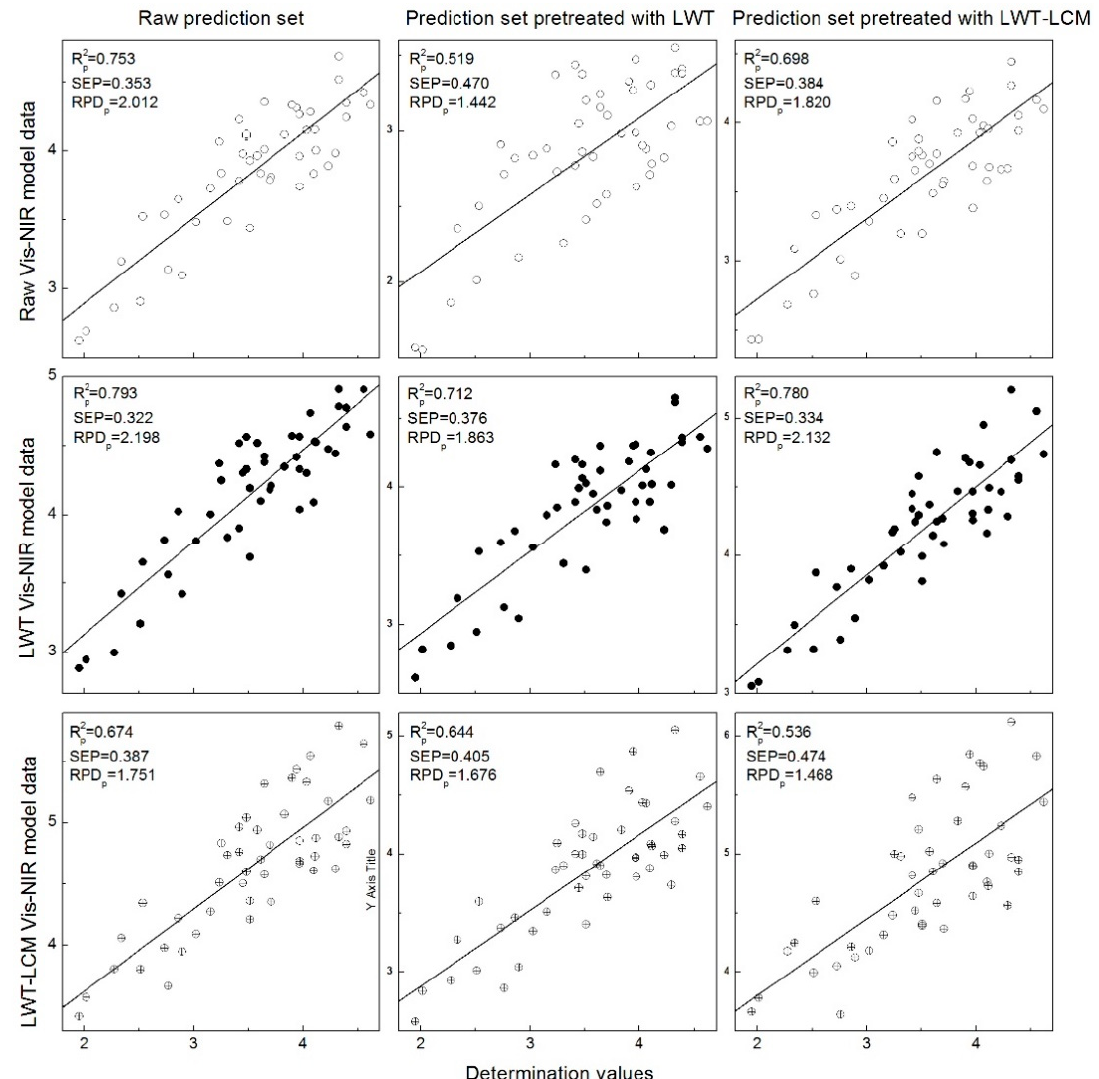
Figure 6. Predicted versus measured wood tracheid length for various prediction sets.